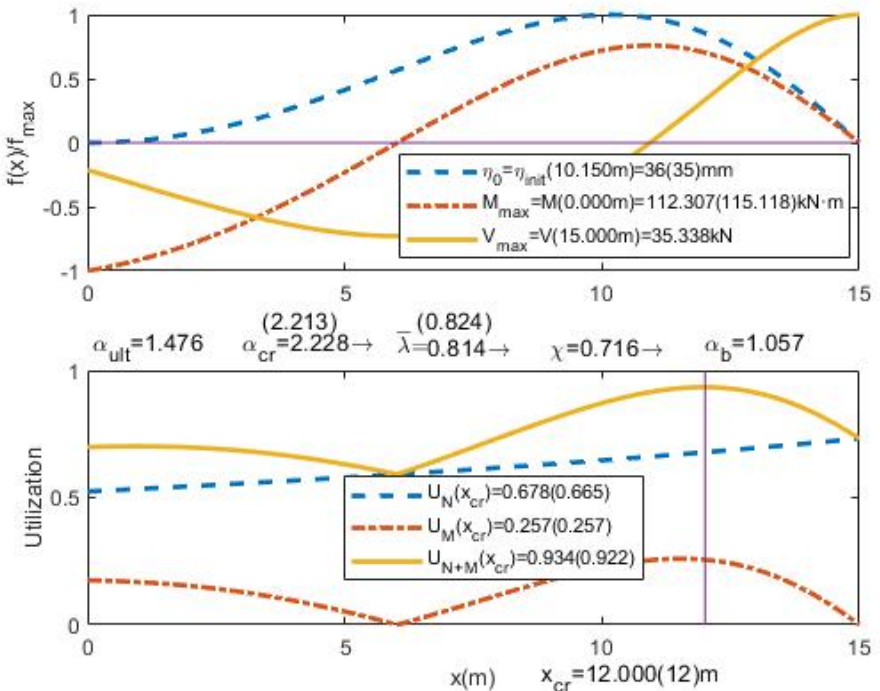
Figure 9. Example 3: UGLI imperfection η init , bending moment M , shear force V , and utilization factor U . Values in brackets are from [7,10].